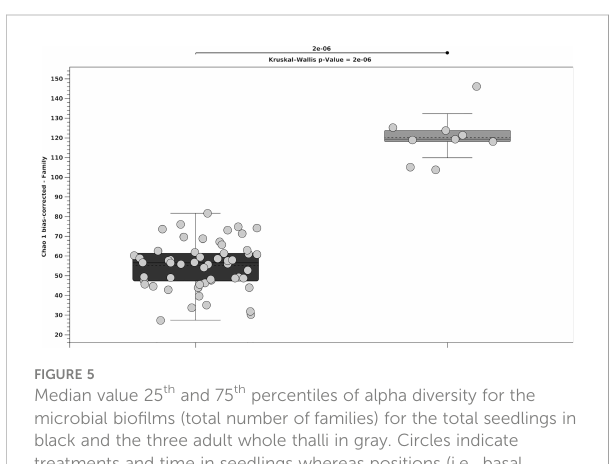
Beta diversity showed the differences among microbial communities when comparing adult thalli vs seedlings (Figure 7) and treatment vs treatment (Figure 8). PCoA showed that the adult thalli were separated from the seedlings (Figure 7). PCoA showed that the treatments had their own trajectories over time (Figure 8). At T3, C (i.e., the seawater control) was separate from the others, supporting the hypothesis that the treatments affected beta-diversity. We also noted a gradient, along the PCo2 axis according to Algatron concentration.